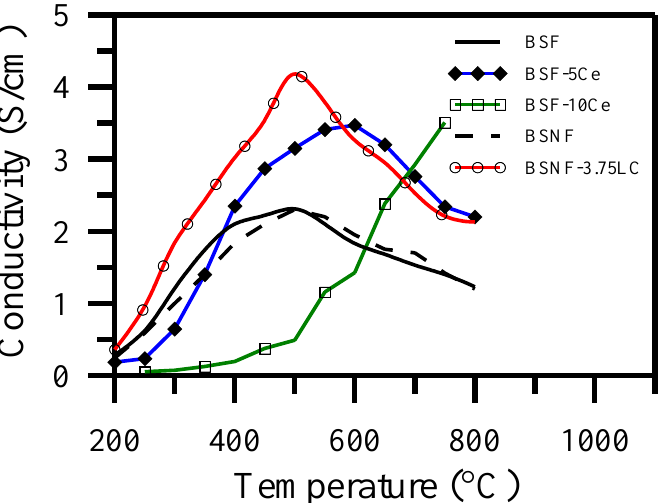
Figure 11. DC conductivity as function of temperature measured in air for BSF, BSF-y Ce (y = 5, 10), BSNF and BSF-3.75 LC [72].